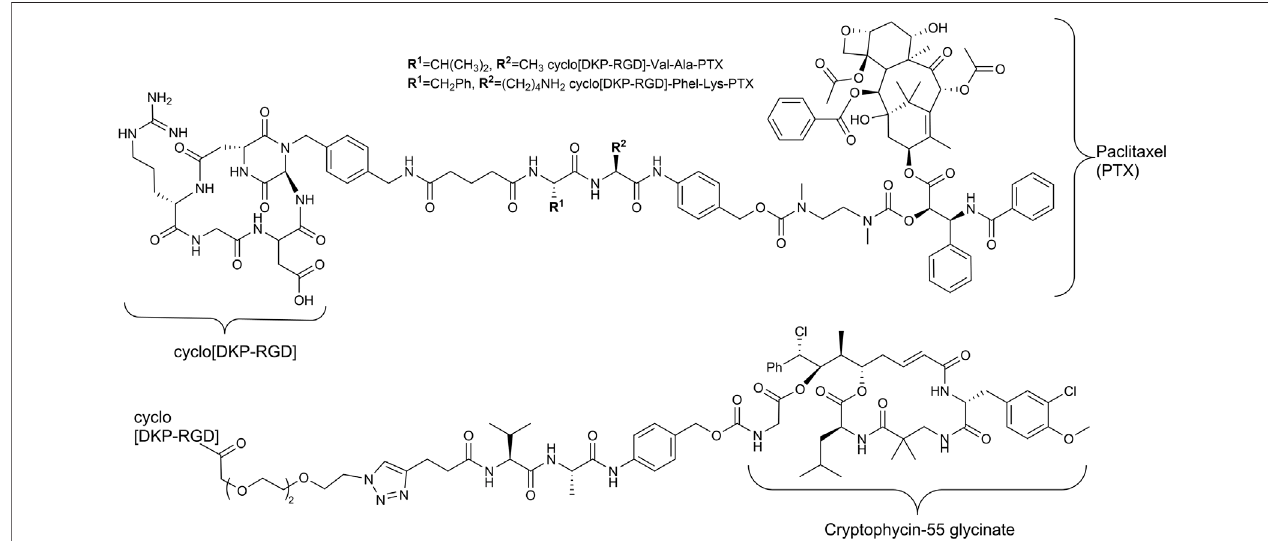
FIGURE 2 | Structures of RGD containing SMDC with enzymatically cleavable linkers and paclitaxel (Pina et al., 2017) as well as cryptophycin-55 (Borbély et al., 2019a) as